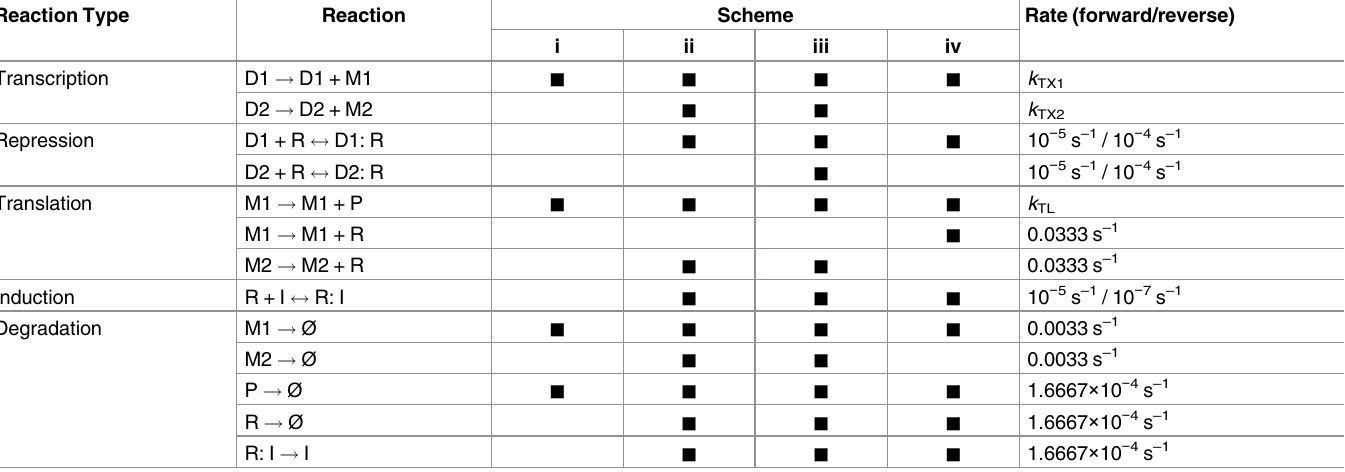
Table 1. List of chemical reactionsin stochastic simulations and reaction rates. The networkschemes in Fig 1A can be simulatedby including the reac- tions with black squaresfor (i) constitutive expression, (ii) constitutive repressor, (iii) autoregulated repressor and (iv) bicistronic autoregulation.Rates fixed in all simulations (when not set to zero) are listed belowalong with names of variable reaction rates. The number of free inducermoleculeswas kept constant. Reaction